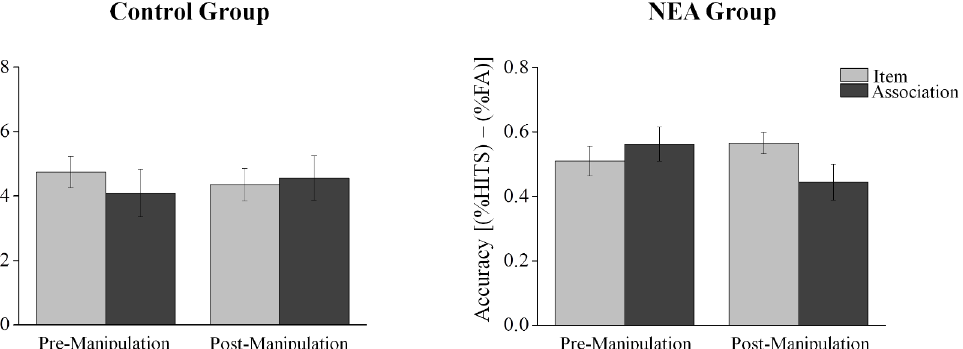
Fig 3. Behavioral results. Memory performance on items and the associative recognition tests in the pre-and post-negative emotional arousal (NEA) manipulation for each group. The measure used is proportion hits minus proportion false alarms, and the error bars represent the standard error of the mean.